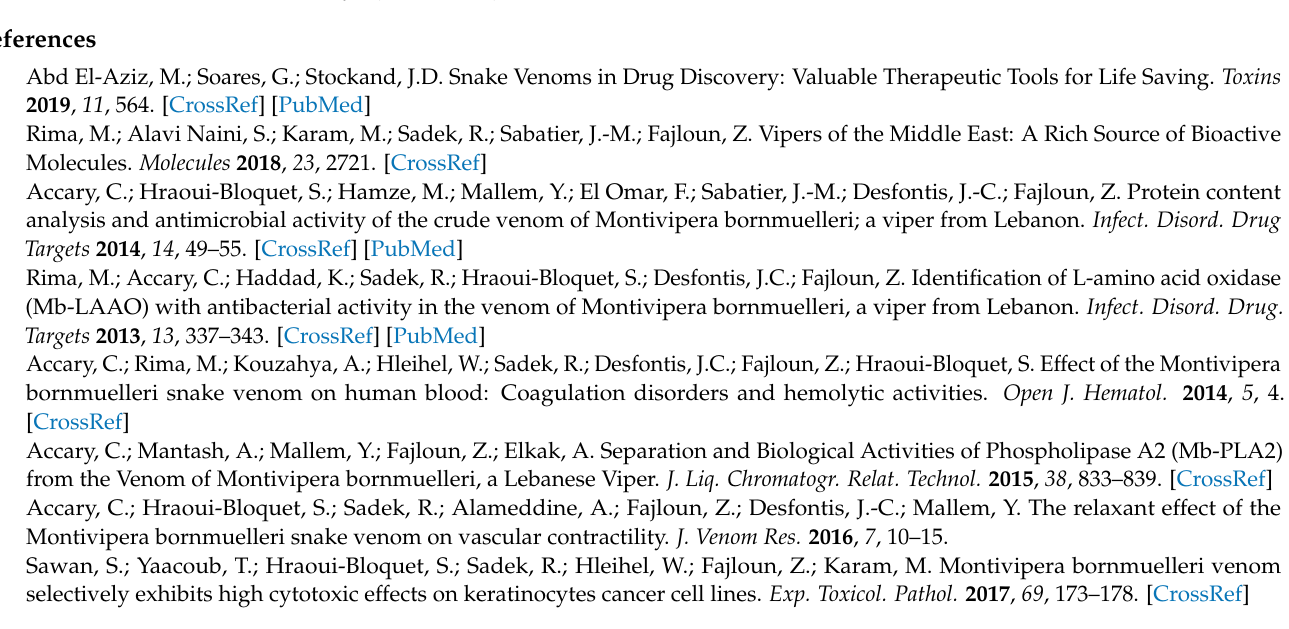
Figure A1. Neurotoxic activity of M. bornmuelleri ’s venom on primary cortical and P19-derived neurons. Water and Triton (10%) were used as the negative (NC) and positive (PC) controls, respec- tively. * p ≤ 0.05; ** p ≤ 0.01.